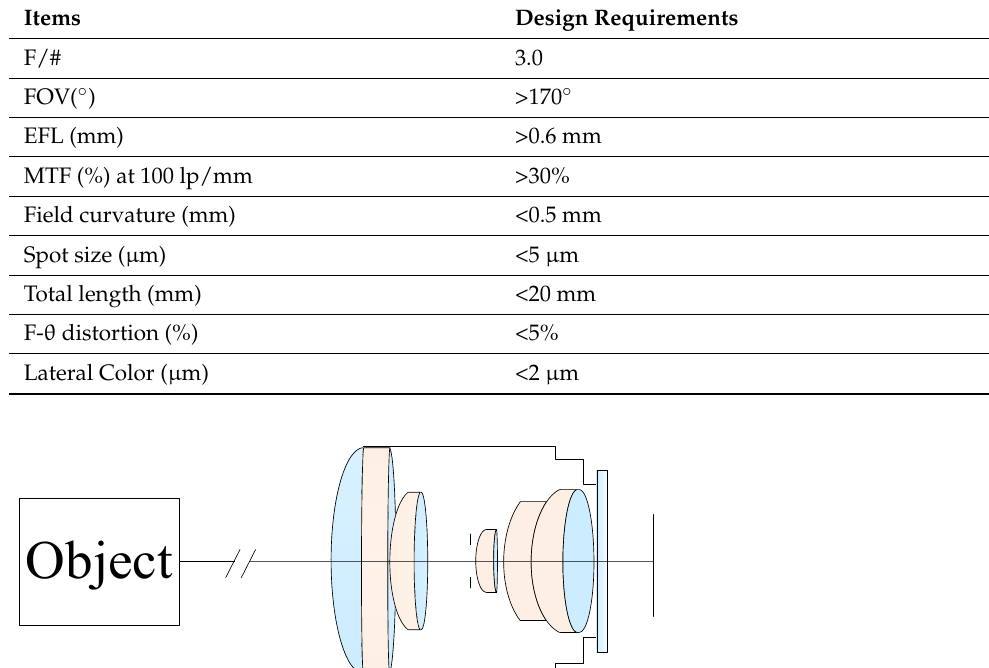
Table 1. Design specifications of a miniaturized wide-angle fisheye lens.